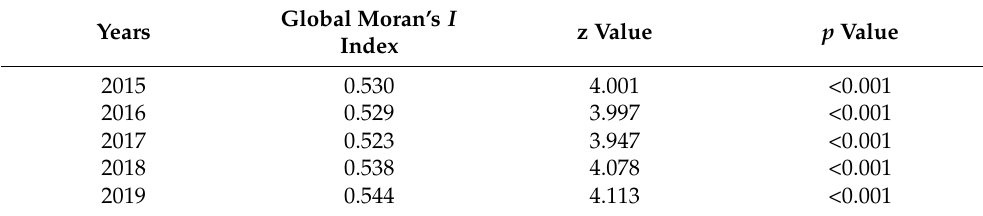
Table 4. Global Moran’s I